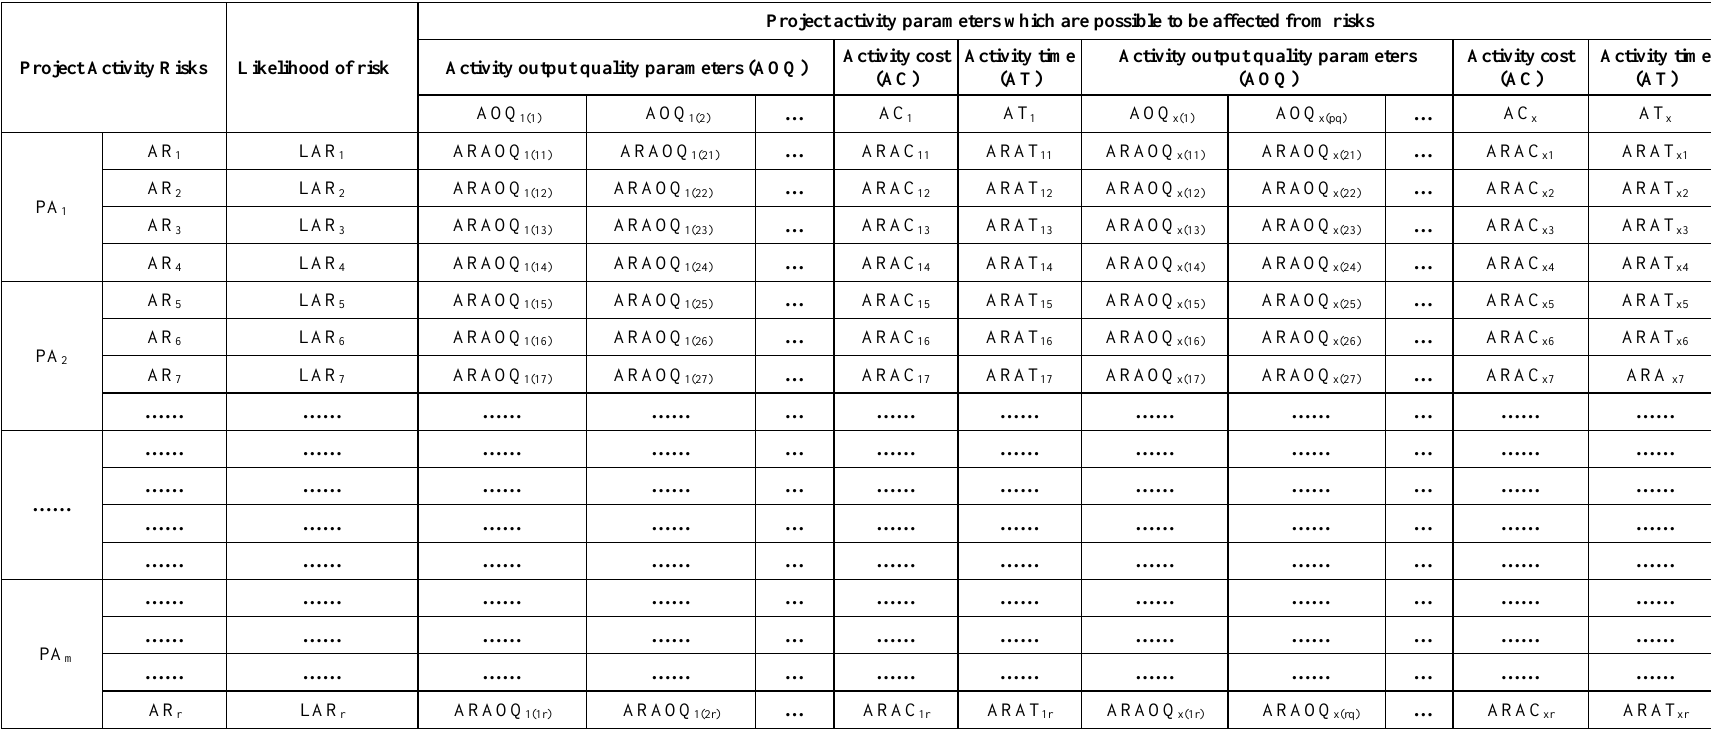
Table 1. Relationship between activity risks, likelihood of risks and project activity